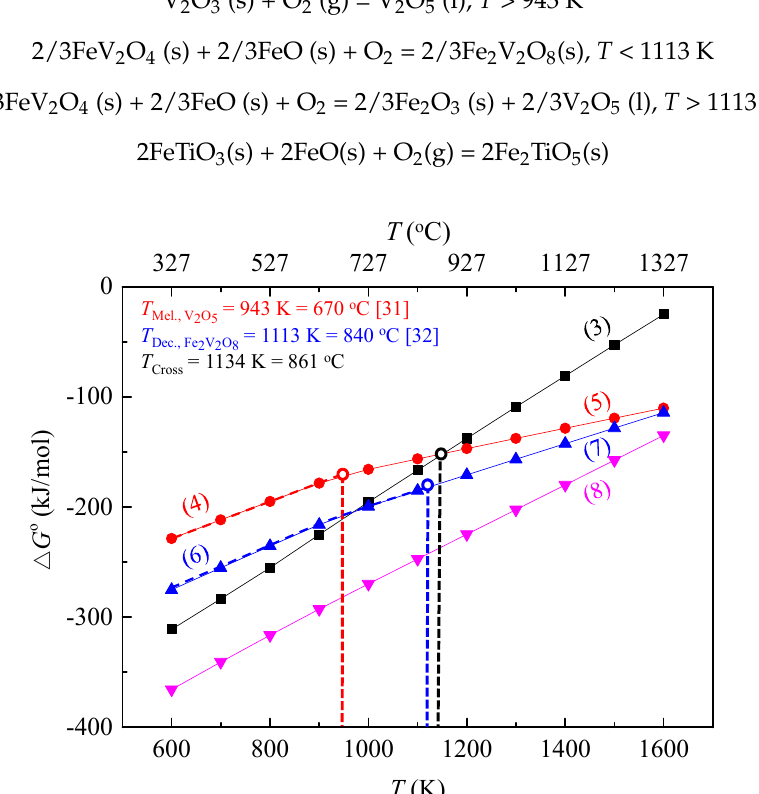
Figure 1. Standard Gibbs free energy diagram of some reactions. Reproduced with permission from [31], Copyright © 1995 VCH Verlagsgesellschaft mbH.